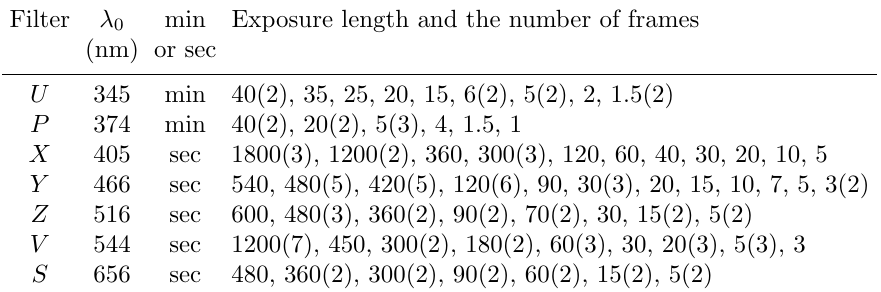
Table 1. Log of observations. The first two columns give the filter name and its mean wavelength. The numbers of multiple frames of the same exposure length are given in